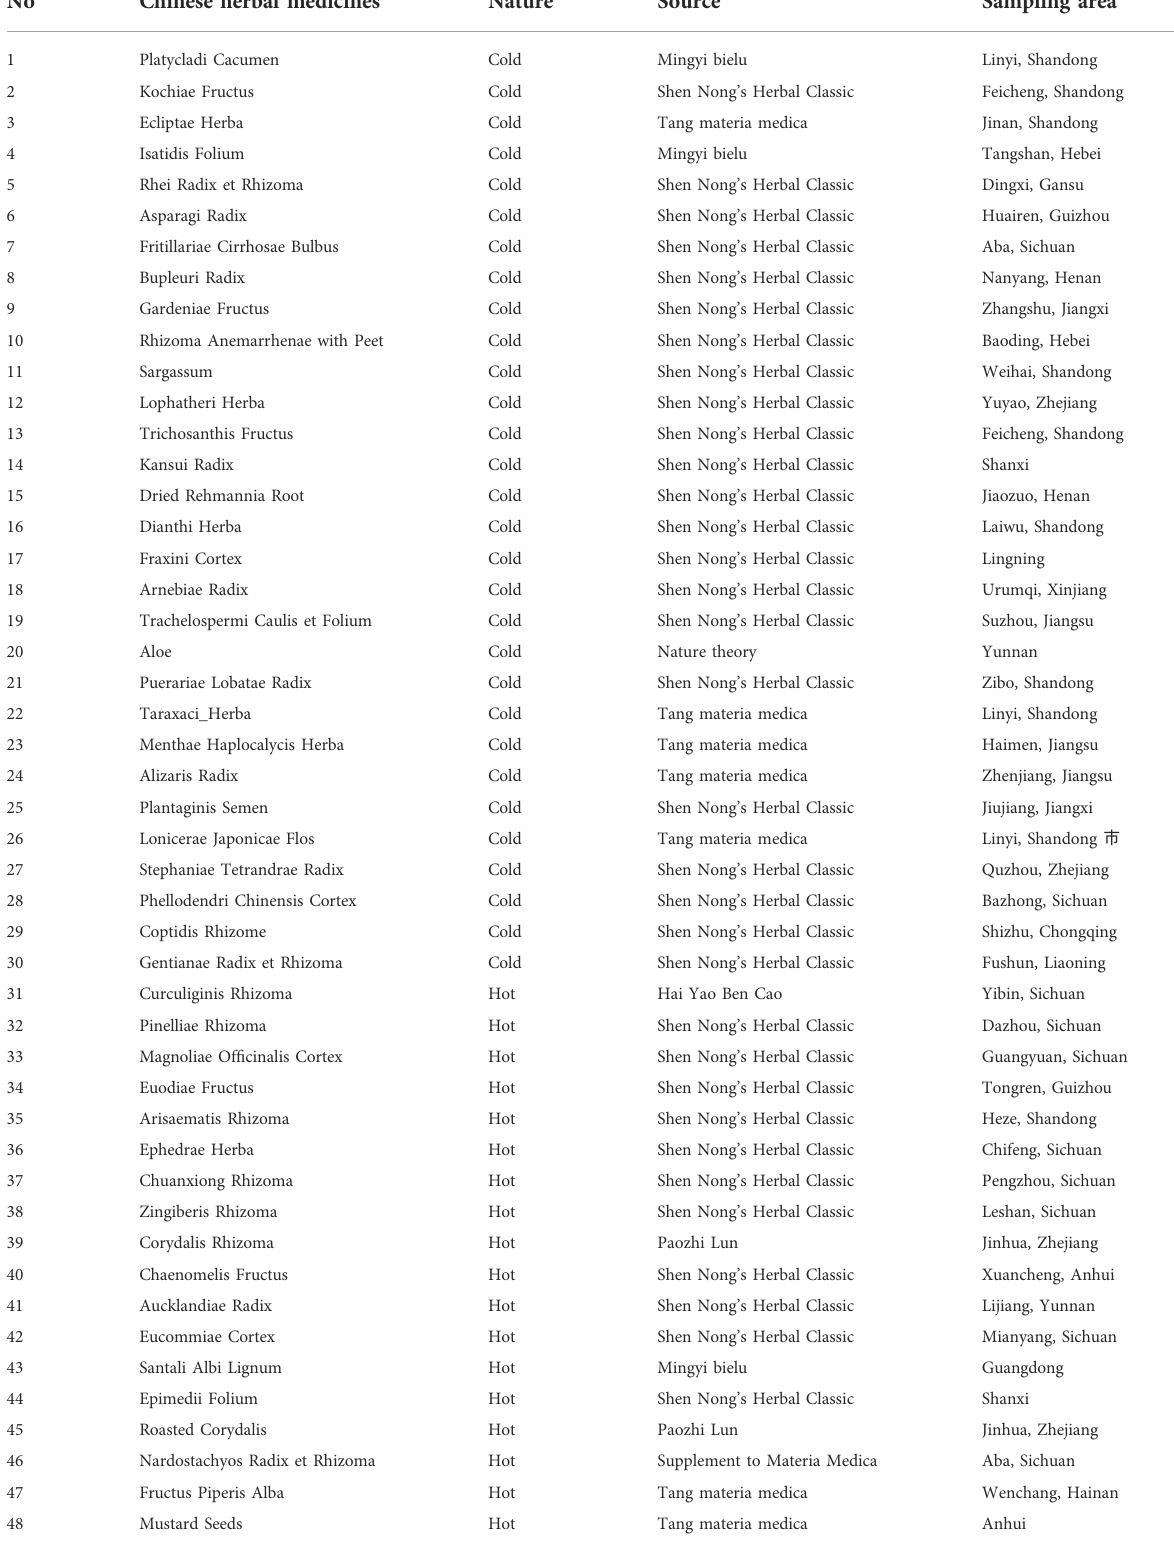
TABLE 1 The experimental 61 representative